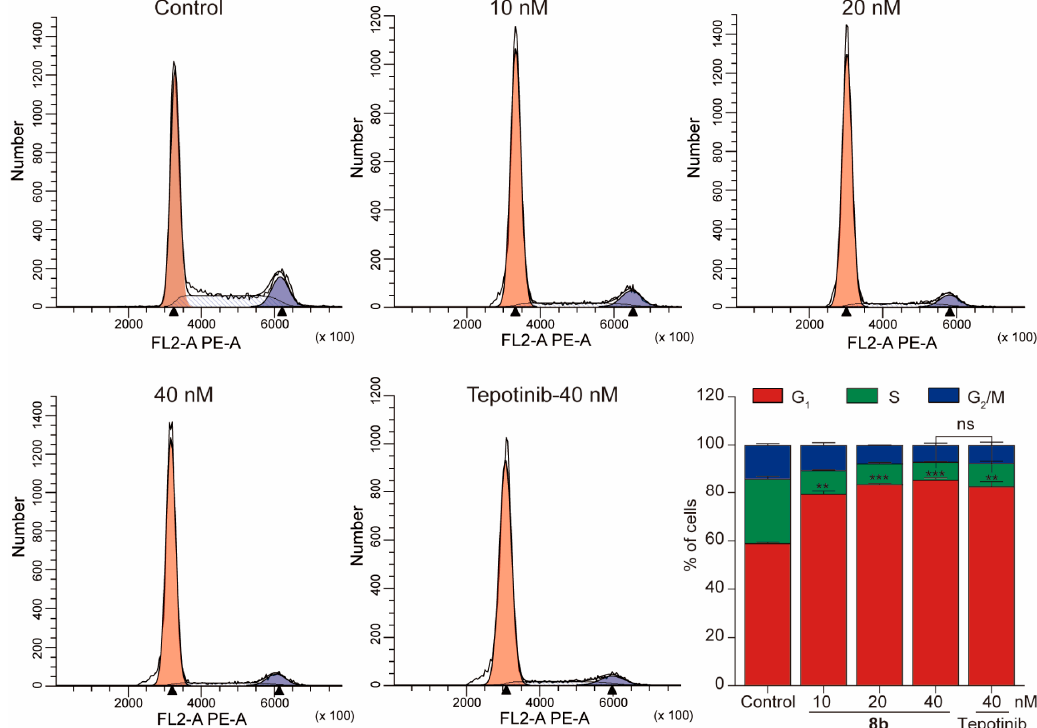
Figure 5. Compound 8b induced the G 1 phase arrest in MHCC97H cells. The MHCC97H cells were treated with compound 8b (10, 20 and 40 nM) for 24 h, harvested, fixed with 70% ethanol, stained with PI and analyzed by flow cytometry. Histograms show the proportions of cell distribution. ** p < 0.01, *** p < 0.001.